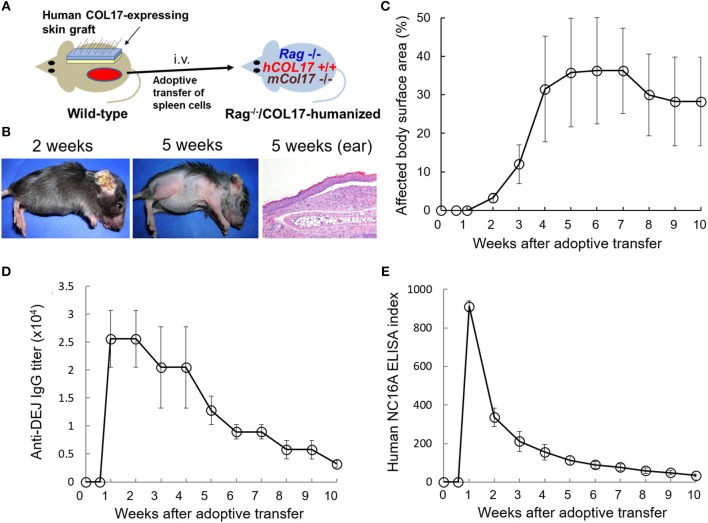
Antibodies to the NC16A domain of COL17 decrease more rapidly than those to the dermal-epidermal junction (DEJ) in an active BP mouse model. (A) Schematic of the generation of an active BP mouse model. (B) Representative clinical presentations of the active BP model at 2 and 5 weeks after the adoptive transfer of immunized spleen cells and hematoxylin and eosin staining of the ear at 5 weeks (original magnification × 20). (C) Time course of disease severities for the Rag−/−/COL17-humanized recipients (n = 4). (D) Time course of titers of circulating IgG antibodies to the dermal-epidermal junction (DEJ) of the skin as determined by indirect IF using sera of an active BP model and normal human skin (n = 4). (E) Time course of the titers of circulating IgG antibodies to the NC16A domain as determined by ELISA (n = 4). Results are shown as mean ± SEM.